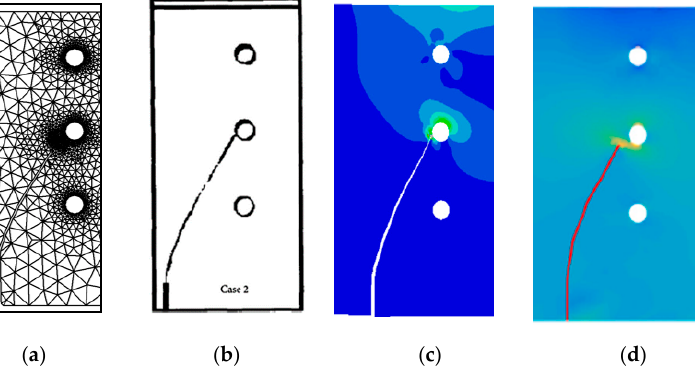
Figure 13. Final crack growth path for case I: ( a ) present study, ( b ) experimental results [32], ( c ) [34] with permission of Elsevier 2018, and ( e ) [35] with permission of Elsevier 2020.